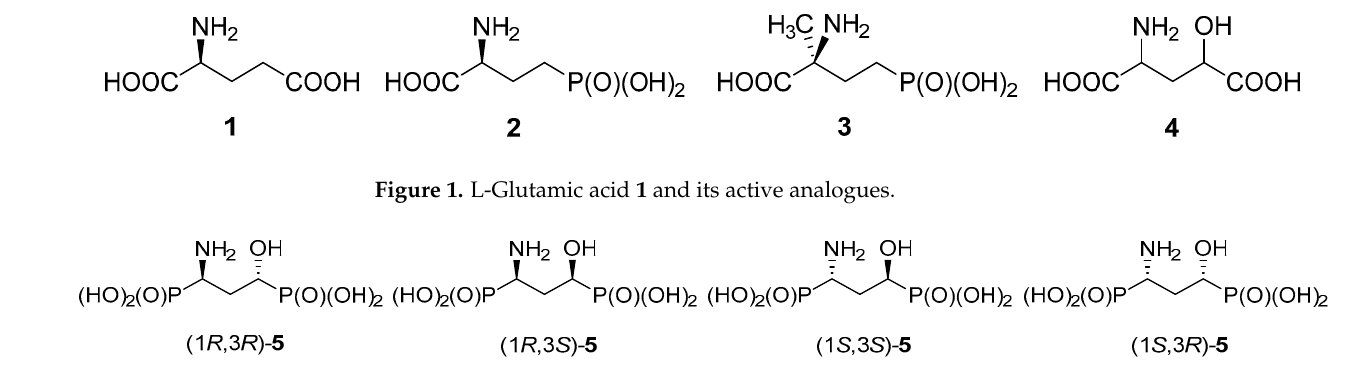
Figure 2. Four enantiomers of (1-amino-3-hydroxypropane-1,3-diyl)diphosphonic acid 5 .